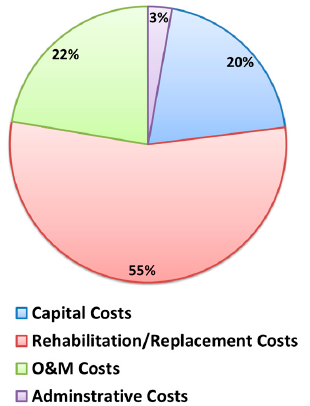
Water 2019 , 11 , x FOR PEER REVIEW Figure 7. Distributed capital, rehabilitation and O&M costs over 25 years lifetime of project.